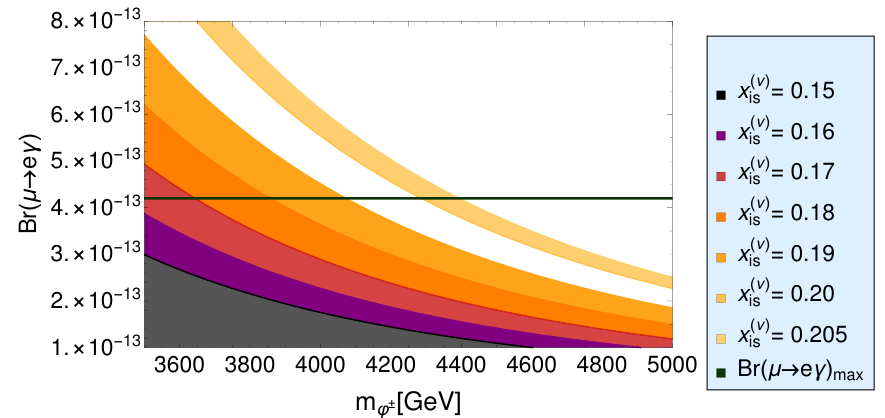
Figure 4 . Branching ratio for the µ → eγ decay as function of charged scalar masses m for different values of the x ( ν ) couplings. The horizontal line corresponds to the experimental js upper bound of 4 . 2 × 10 − 13 [170] for the branching ratio of the µ → eγ decay. Here we have set m N = 50